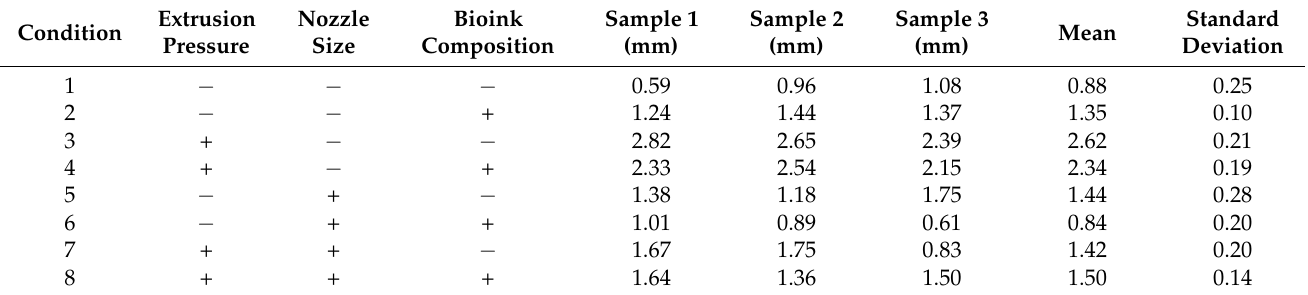
Table 4. Experimental data for shape fidelity measurements (perimeter deviation).